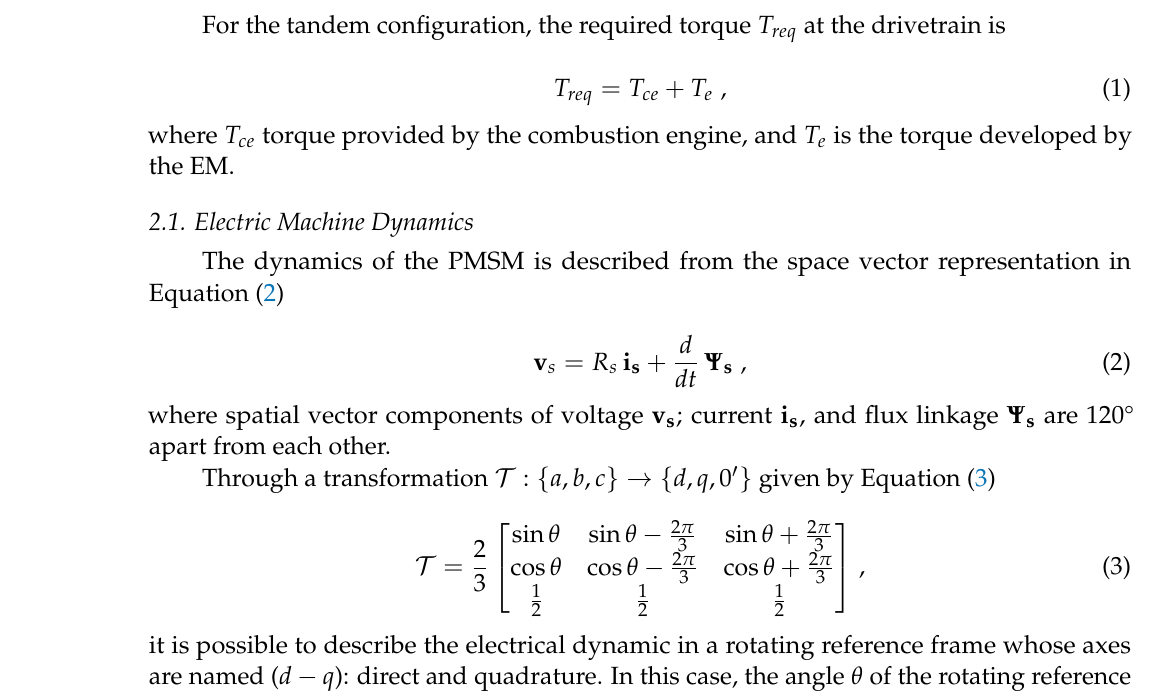
Figure 2. Specific fuel consumption of a HEV and power flow